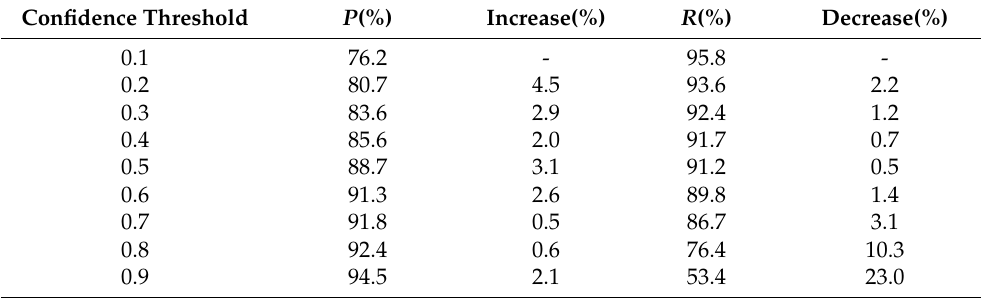
Table 10. The experiment results of RDE-YOLOv7 with different confidence thresholds. Confidence